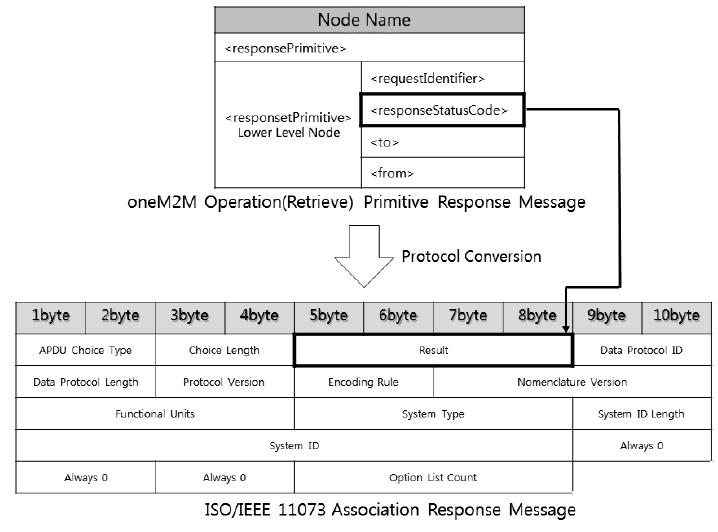
Figure 7. Conversion of a oneM2M Retrieve primitive Response message to an ISO/IEEE 11073 Association Response message.